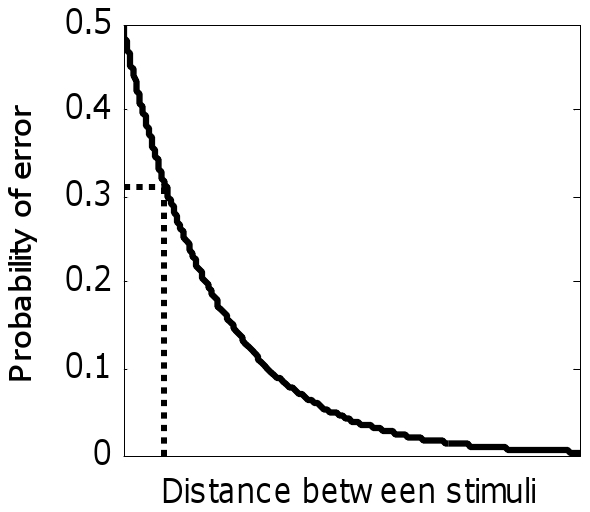
The choice model of Xu et al.
[36], where the probability of error in a two-alternative forced-choice (AXB) task decreases exponentially with increasing distance between stimuli (solid line).Dashed lines correspond to error probability of 0.31, or baseline discriminability between experimental stimuli absent effects of correlation among attributes [22], and the corresponding inter-stimulus distance.